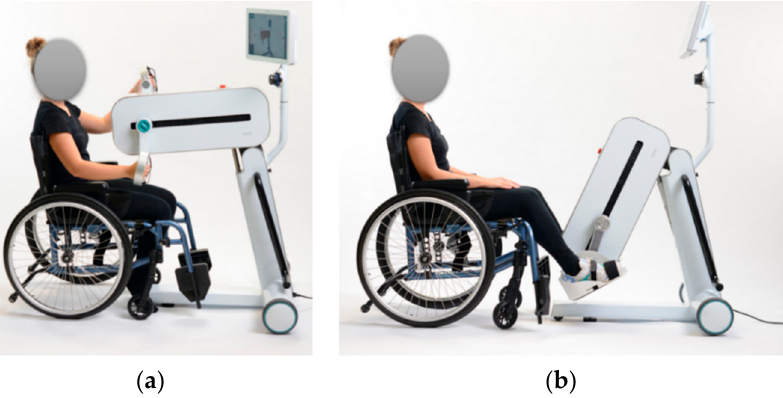
Figure 3. From the left (modified with permission from [47], person’s face obscured): ( a ) LEPRE Rehabilitation Device in the upper-limb setup: central body in upper position and accessories that allow hand grip, and ( b ) LEPRE Rehabilitation Device in the lower-limb setup: central body in lower position and accessories that allow the anchorage of the feet.